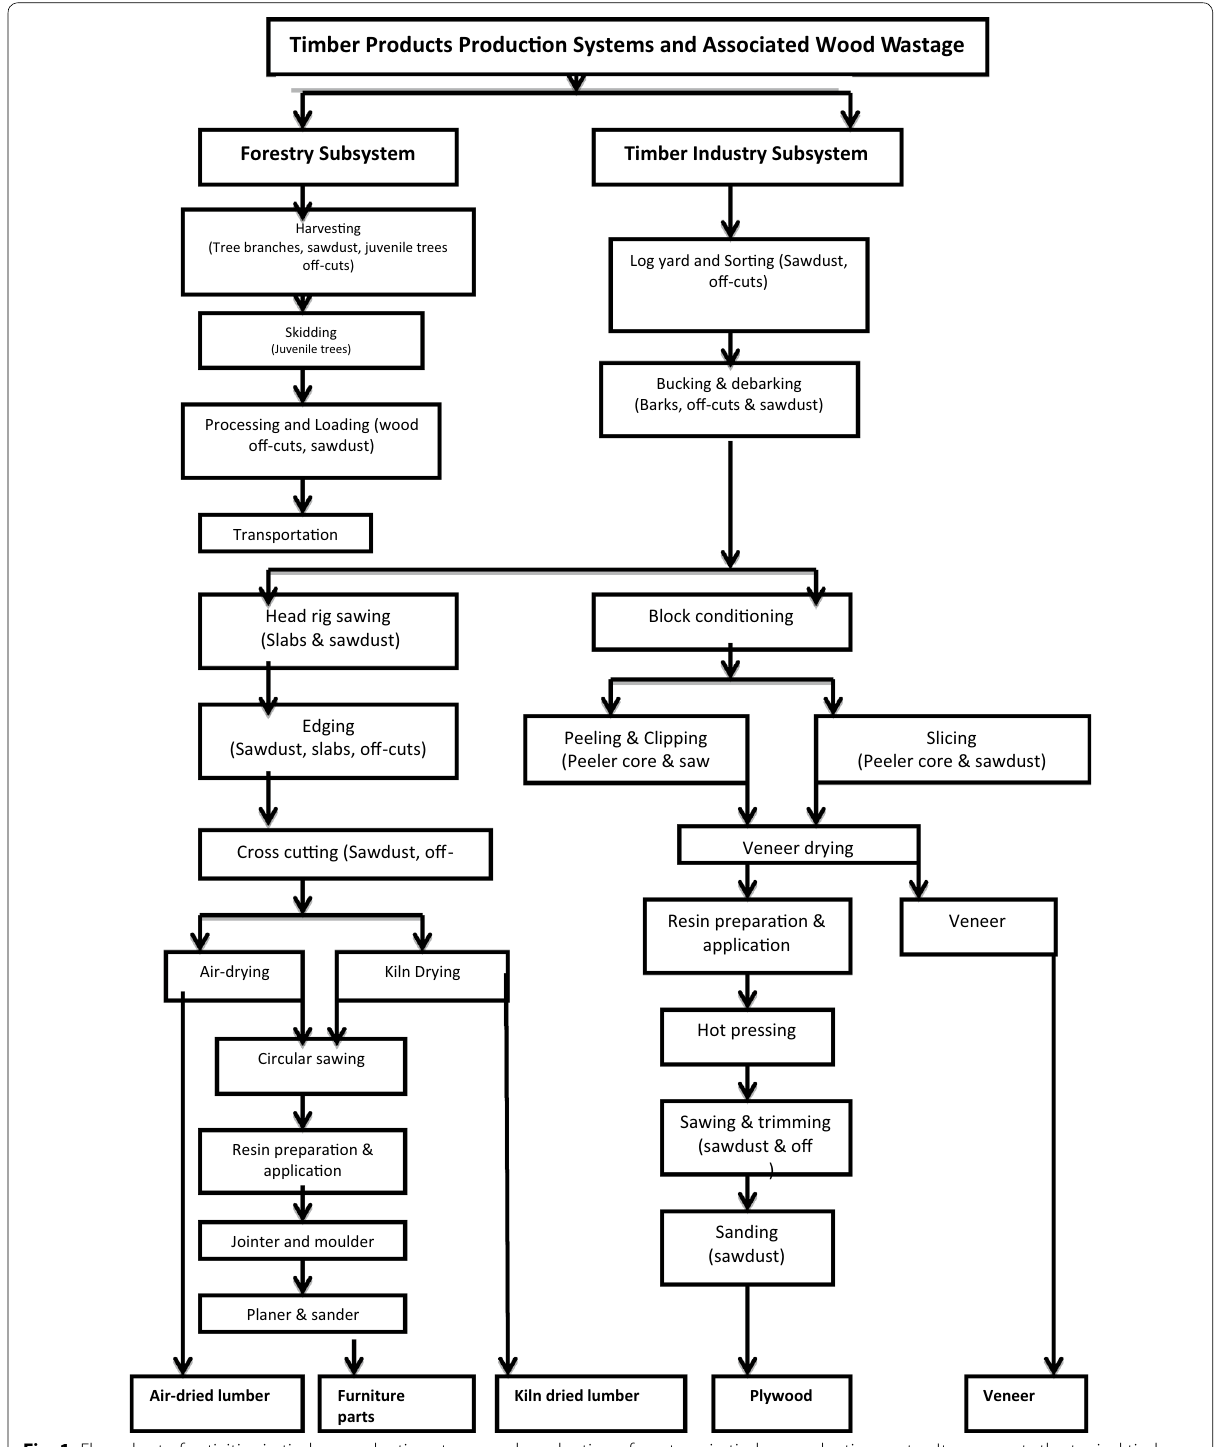
Fig. 1 Flow chart of activities in timber production stages and production of wastage in timber production sector. It represents the typical timber product production system, from harvesting to the final products through two subsystems viz the forestry and timber industry subsystems, within the timber production sector. Modified from Eshun et al.